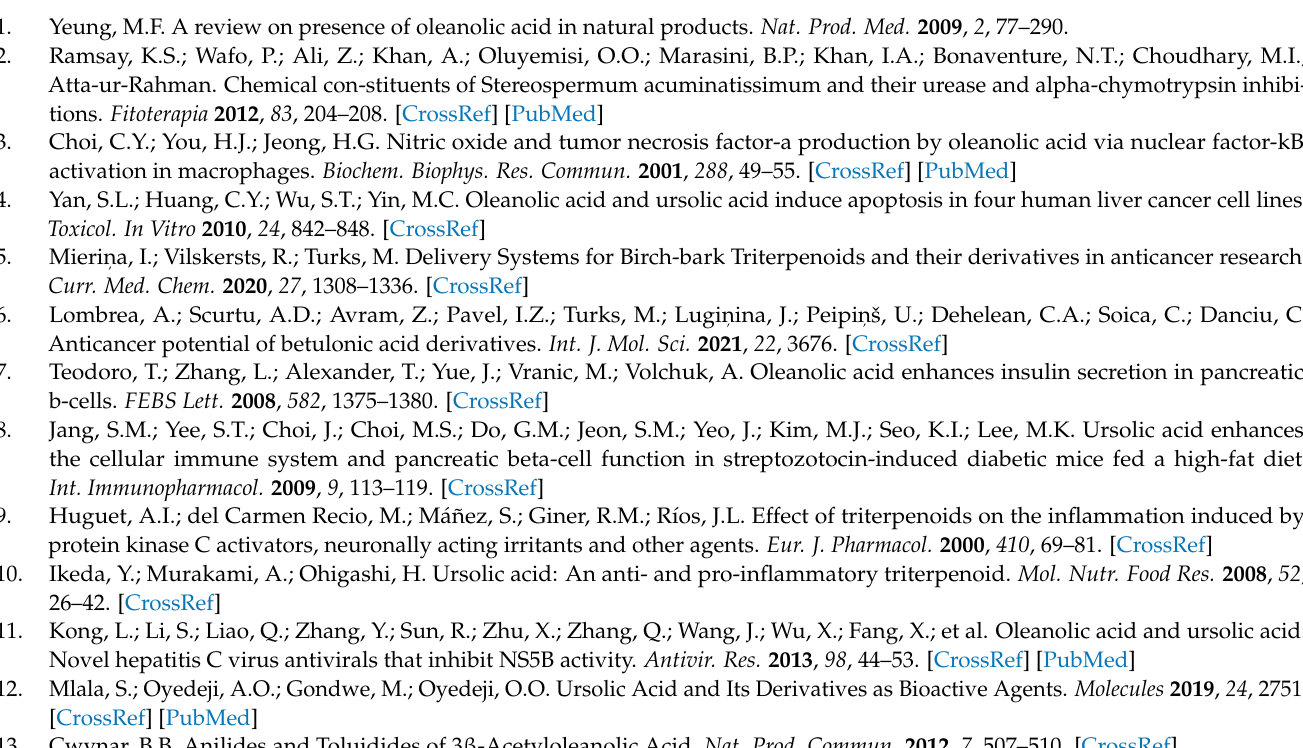
H-NMR spectrum of 3a ; Figure S2: 13 C-NMR spectrum of 3a ; Figure S3: IR spectrum of 3a ; Figure S4: Mass spectrum of 3a ; Figure S5: 1 H-NMR spectrum of 3b ; Figure S6: 13 C-NMR spectrum of 3b ; Figure S7: IR spectrum of 3b ; Figure S8: Mass spectrum of 3b . CheckCIF report and *.cif file for compound 3a as separate